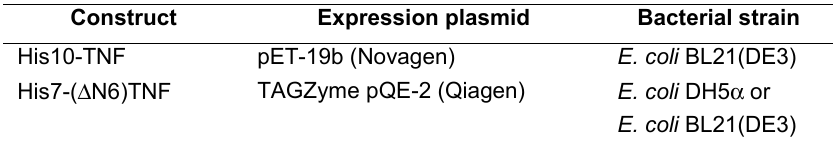
Expression Plasmids and Bacterial